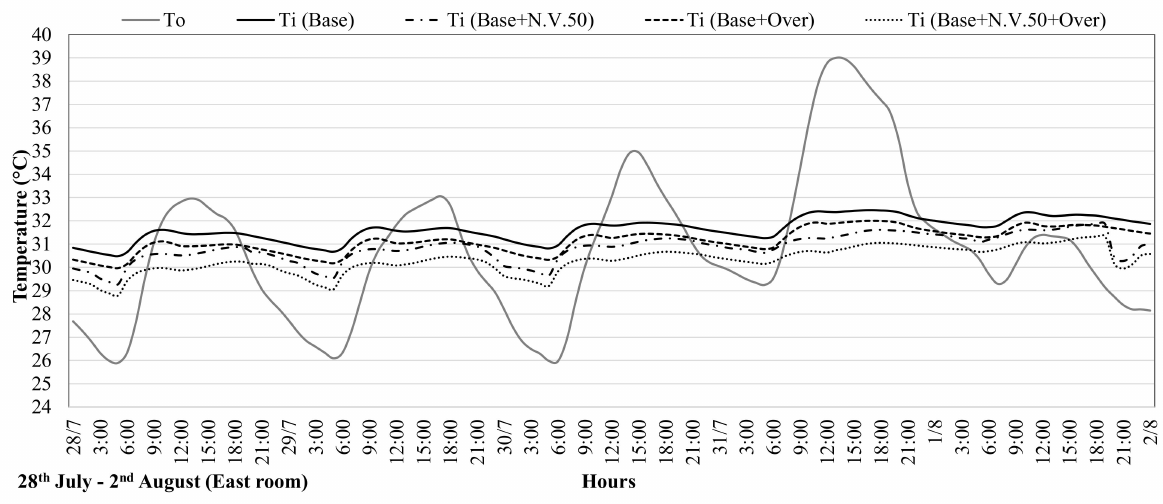
Figure 4. Hourly profiles of indoor air temperature (Ti) in the investigated cases from 28 July to 2